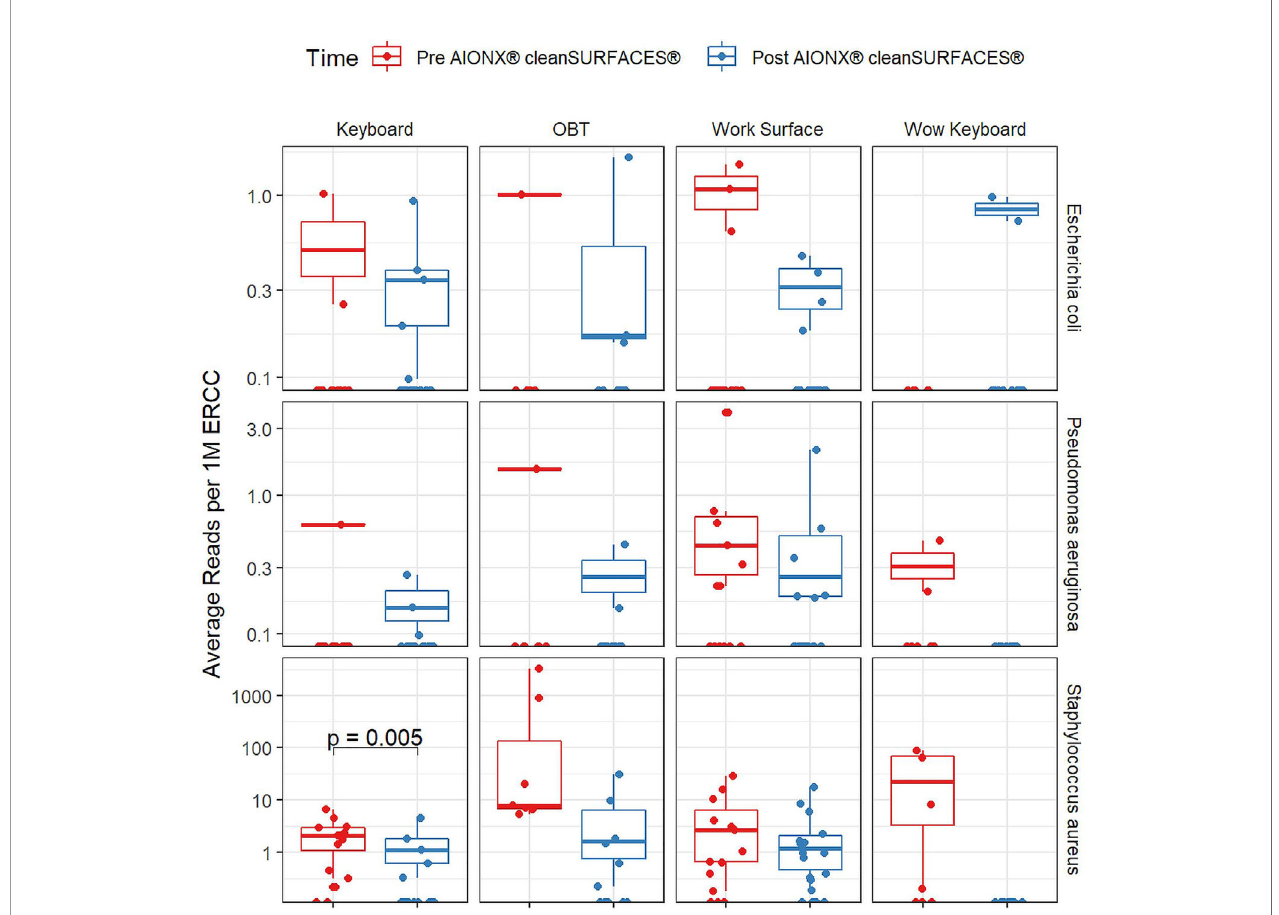
FIGURE 6 | Normalized average transcript count comparison boxplot of “ Common Pathogens ” between surfaces before and after the intervention of the AIONX ® cleanSURFACES ® . Statistically signi fi cant (adjusted p < 0.05) comparisons are marked with an